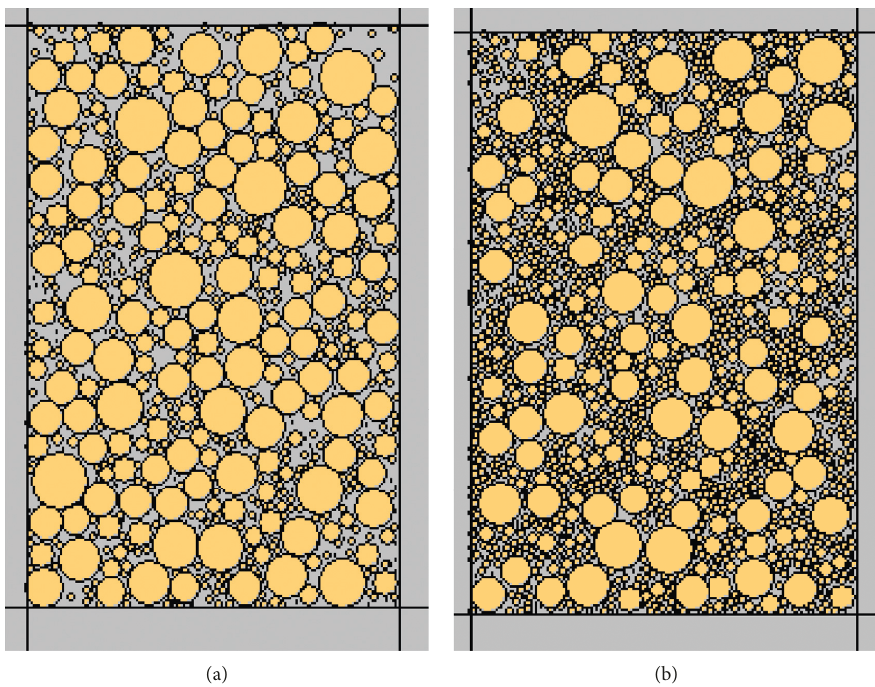
Figure 2: Digital specimens of the graded mixtures. (a) PA-13. (b)